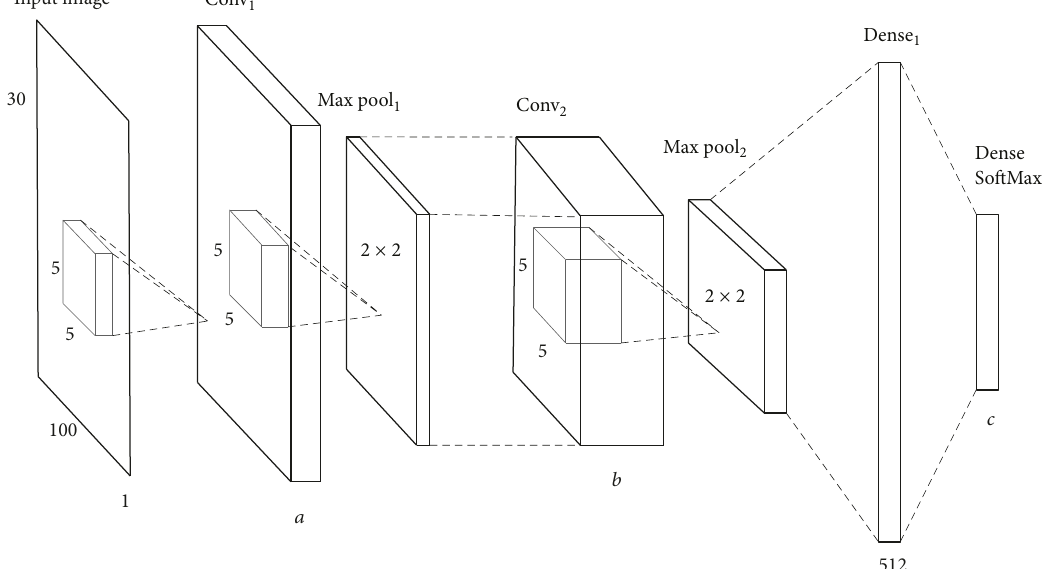
Figure 2: Proposed CNN architecture for demographic problems using